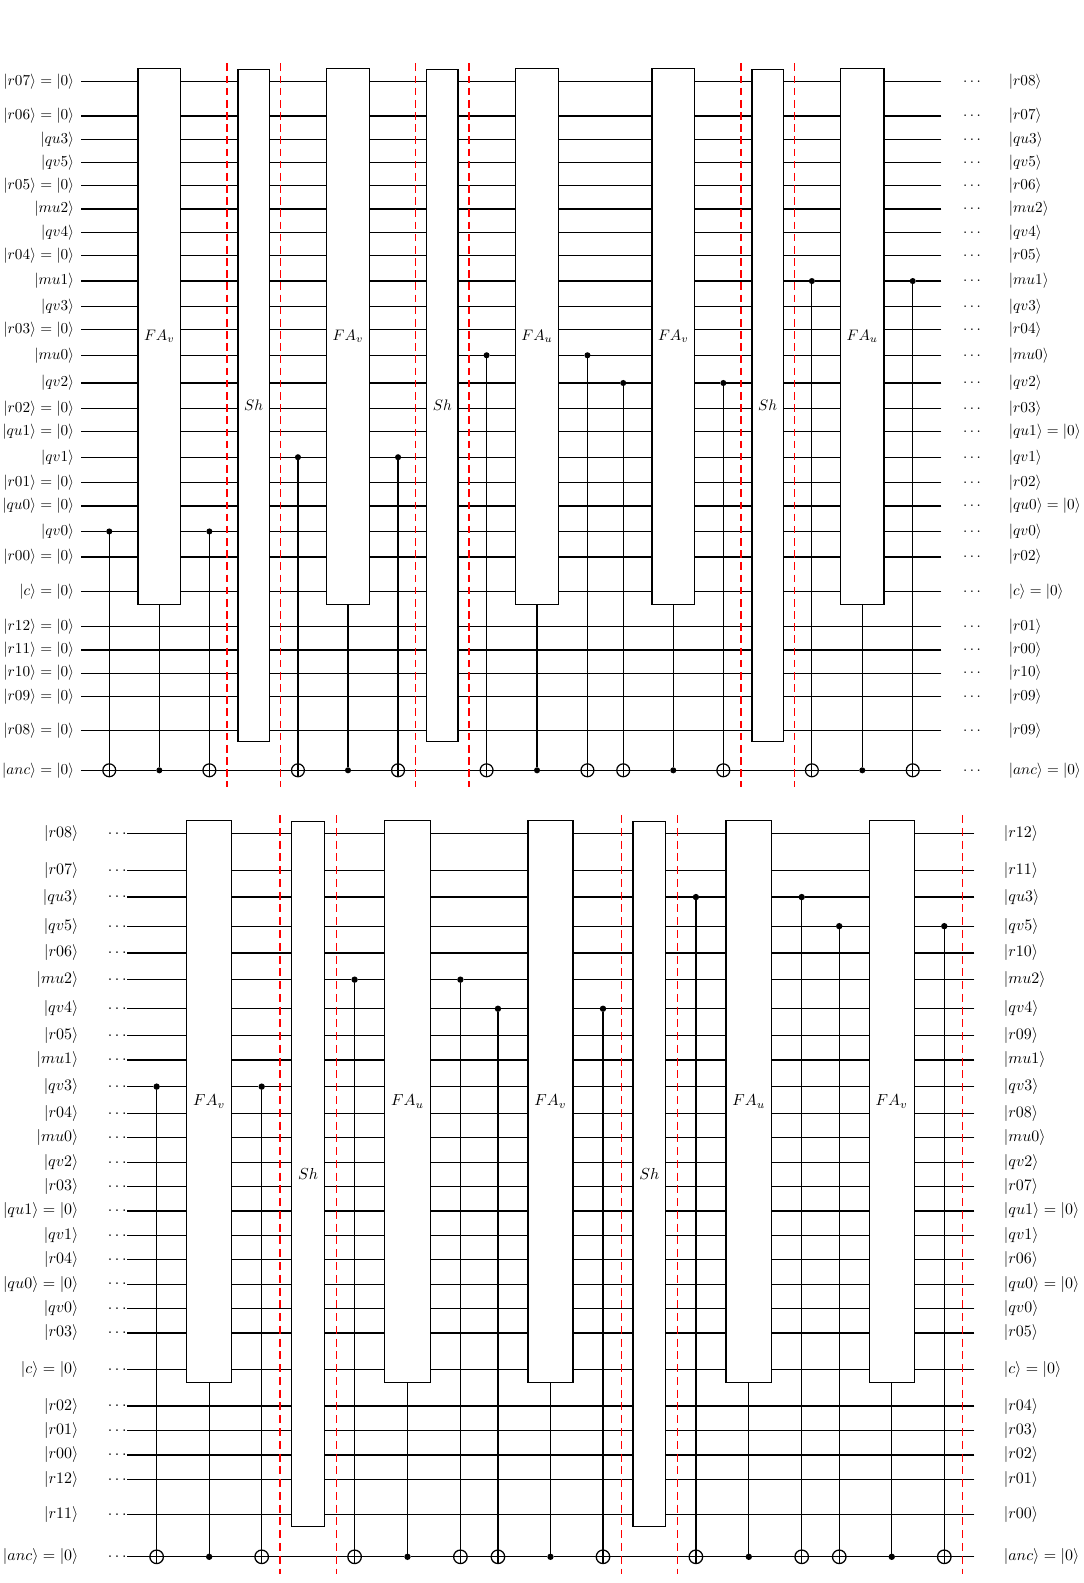
Figure 15. Quantum circuit defining SQ 6 used in the computation of u 2 + v 2 . The scaled velocity components u and v are represented as floating-point numbers with four mantissa qubits ( N M = 4) and three exponent qubits ( N E = 3). The circuit uses modified 7-qubit Cuccaro full adders ( FA u and FA v ) with a 13-qubit results register. Sh performs a ‘downward’ shift of the results